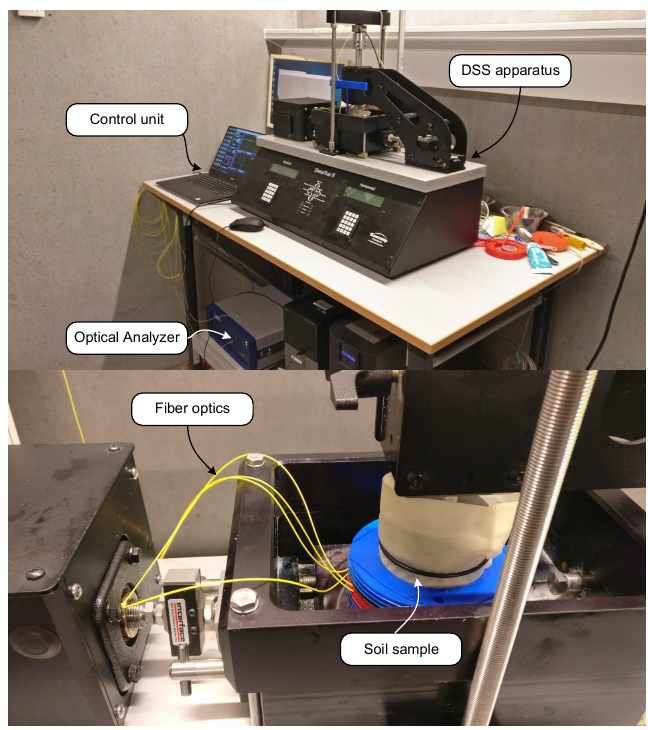
Figure 6. Integrated test